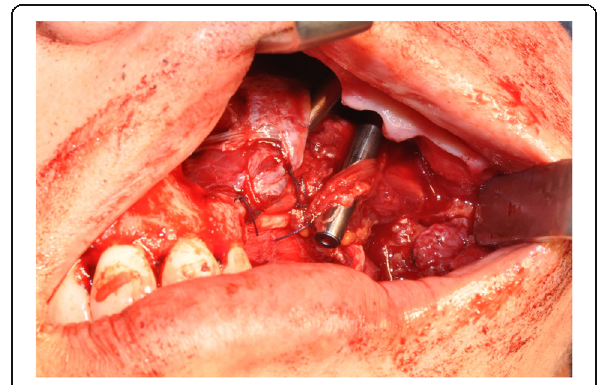
Fig. 11 Pt no. 2. The fascial side of the left temporalis muscle stitched to the mucosal margin to separate the sino-nasal cavity from the oral one